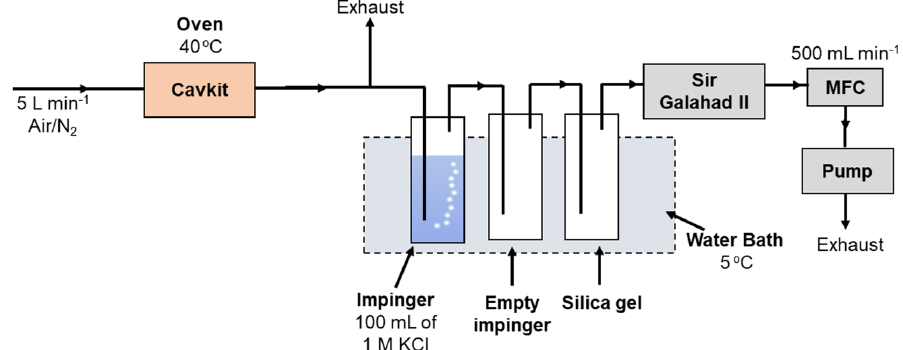
Figure 4. Experimental arrangement for KCl trapping experiments.